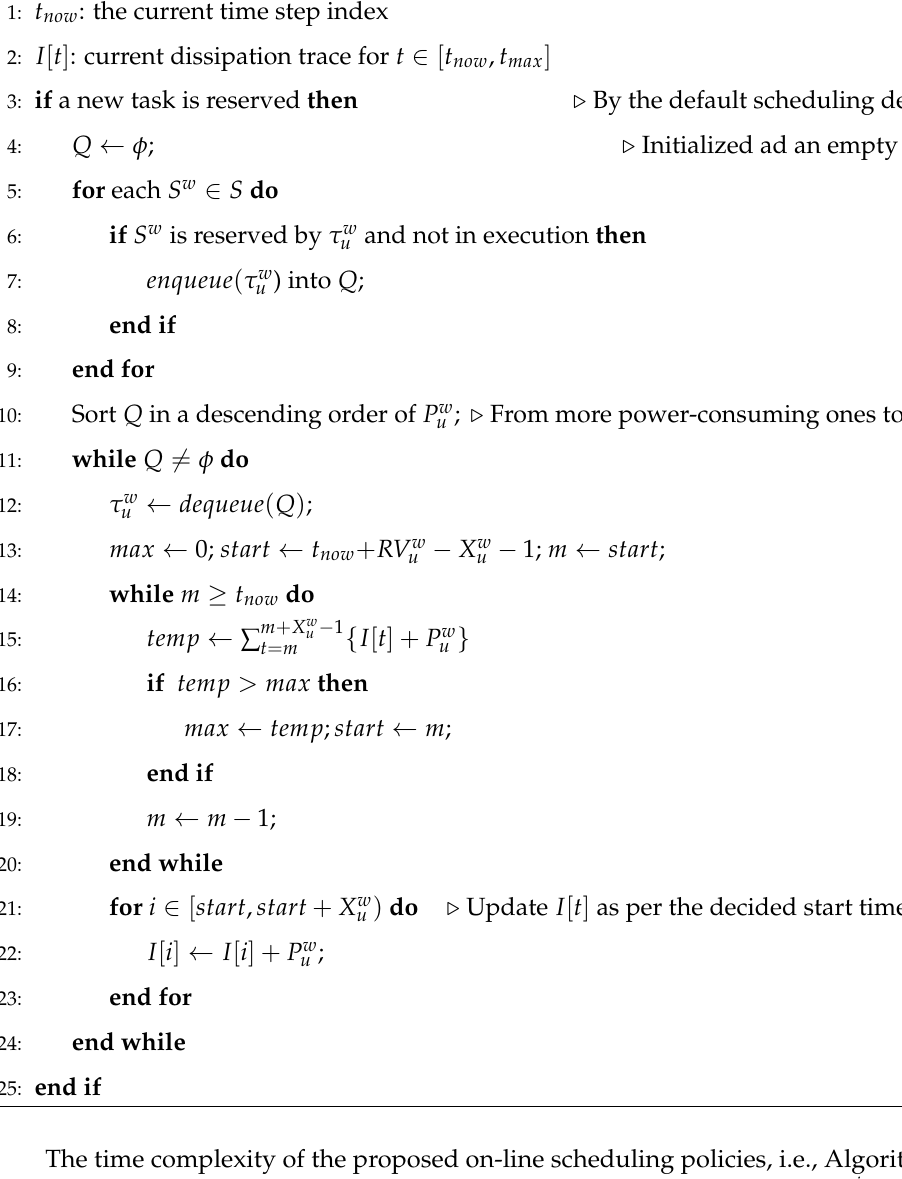
Algorithm 4 Run time scheduling of the reserved tasks in the MAX_VAR_ALAP